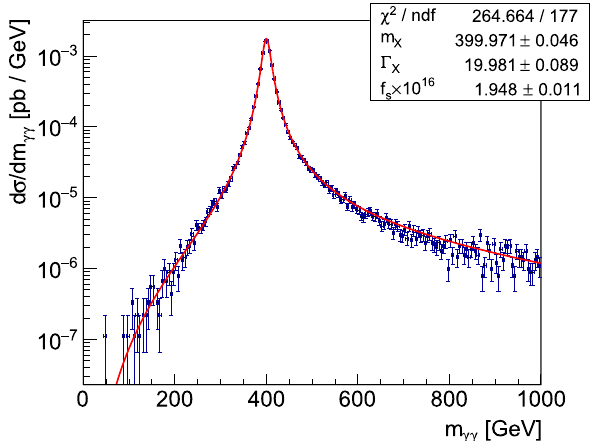
Fig. 2 A fit of the signal differential cross section functional form to a histogram of the MC events generated at the m X = 400GeV, (cid:3) / m = 5% point X X